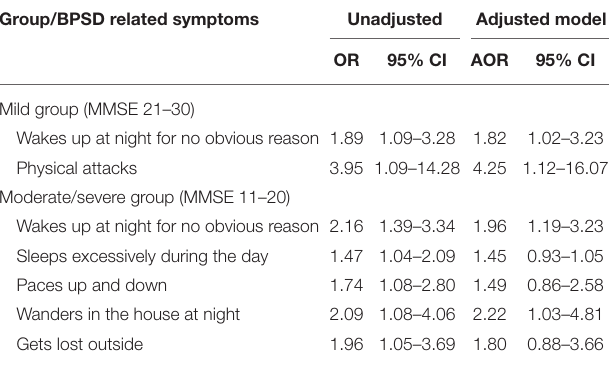
TABLE 3 | BPSD before and during COVID-19: results of multivariate analysis. Group/BPSD related